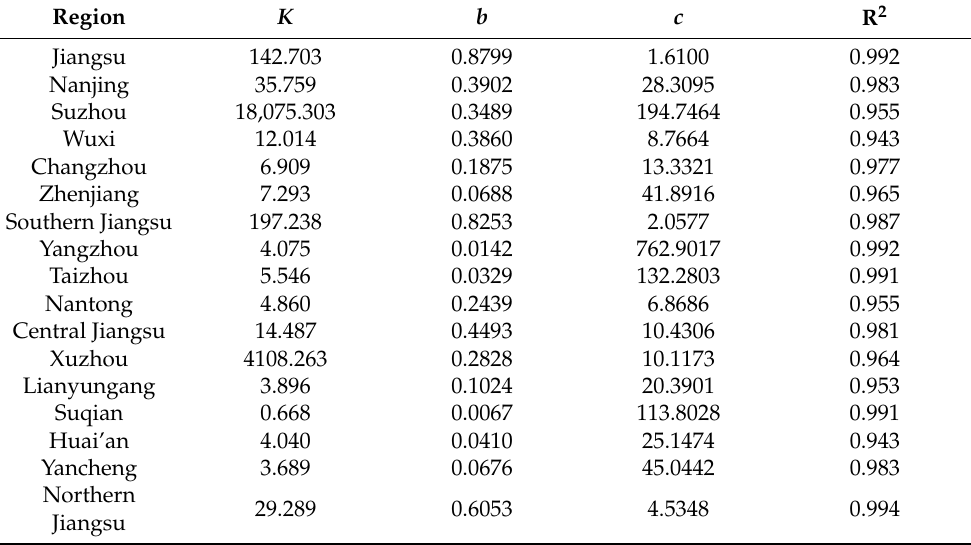
Table 2. Logistic equation parameters of Jiangsu Province, Southern Jiangsu, Central Jiangsu, North- ern Jiangsu and 13 prefecture level